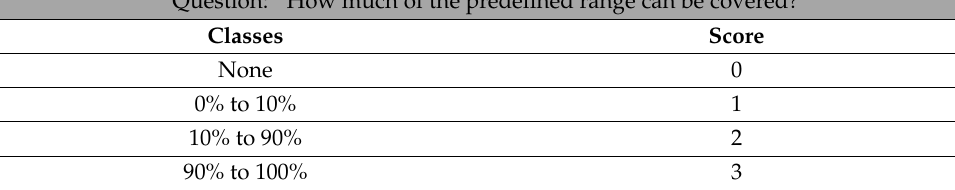
Table 3. RaC sr,pa —range coverage potential.